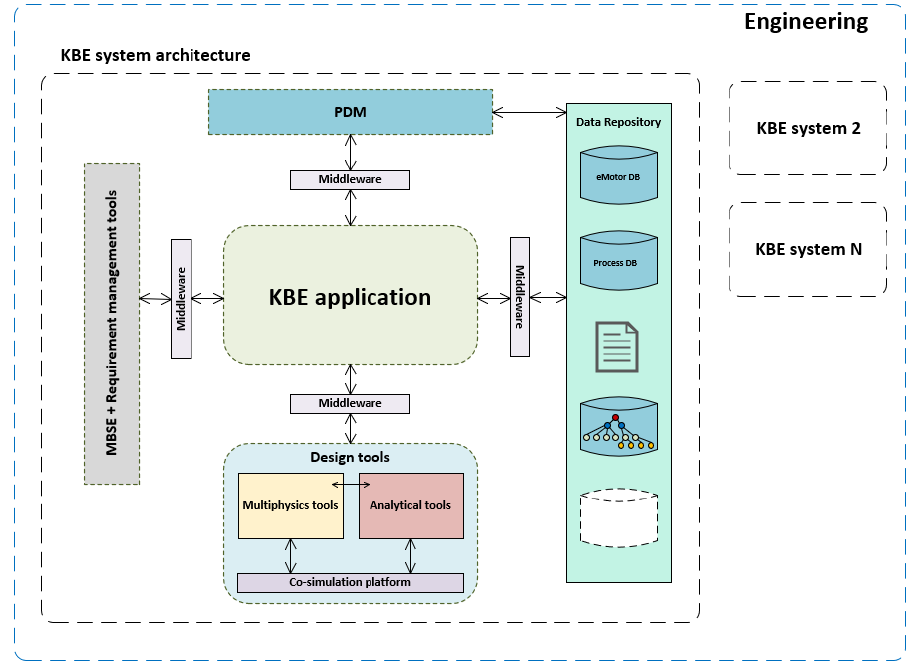
Figure 6. Macro-level and micro-level process knowledge representation illustration.